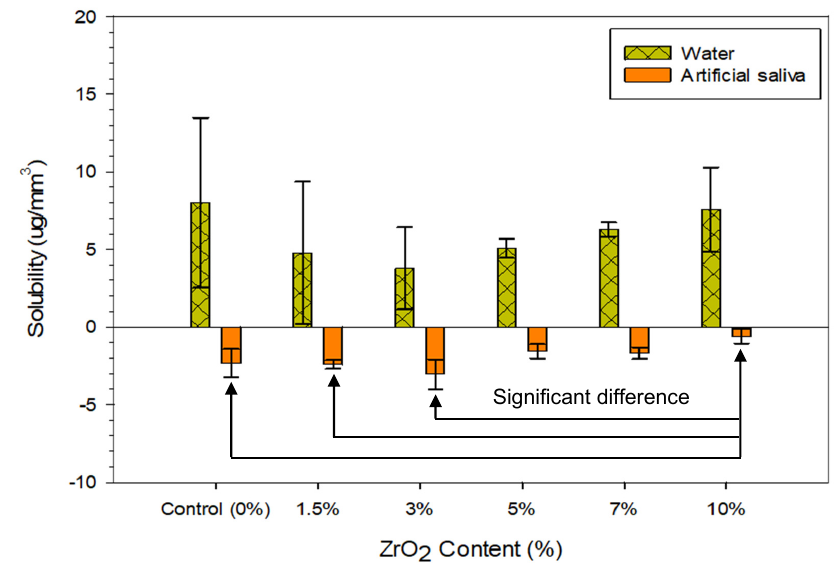
Figure 3. Bar chart demonstrating the mean solubility values of specimens after immersing for 180 days in distilled water and artificial saliva.